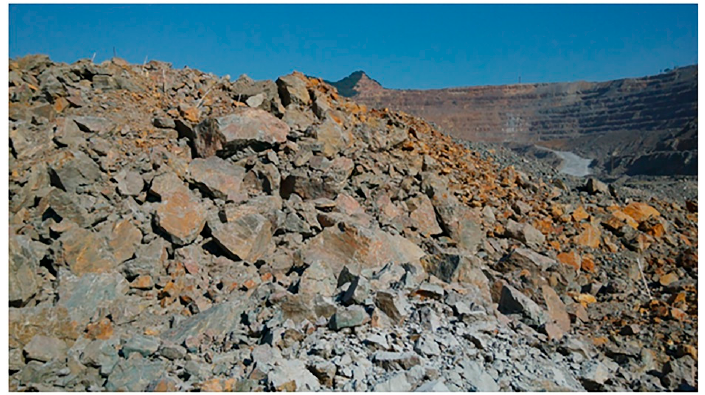
Figure 6. Muck pile on site. Figure 8. Muck pile on site.